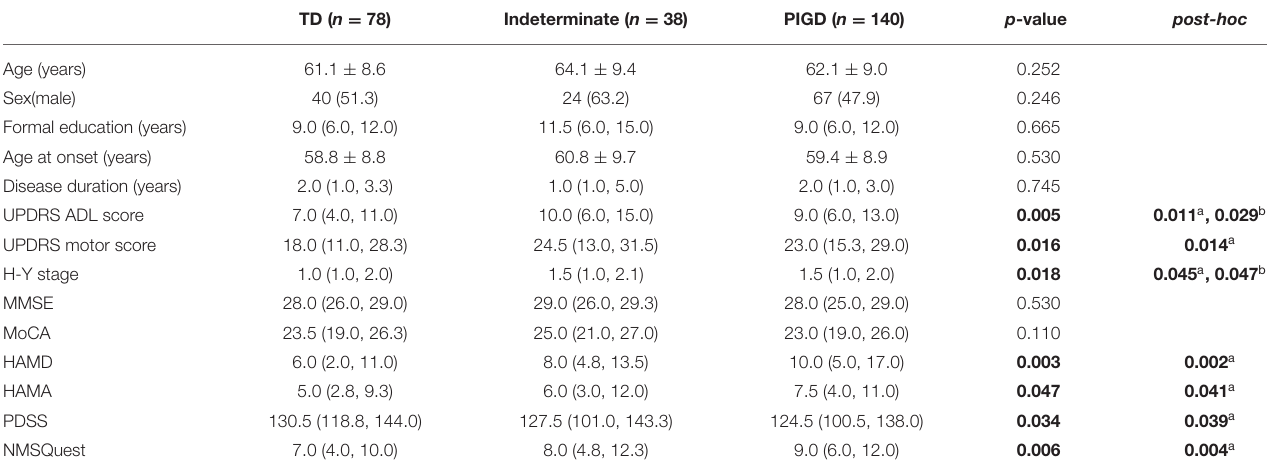
TABLE 3 | Comparison of the demographic and clinical characteristics of de novo Parkinson’s disease patients among the tremor-dominant/indeterminate/postural instability and gait difficulty